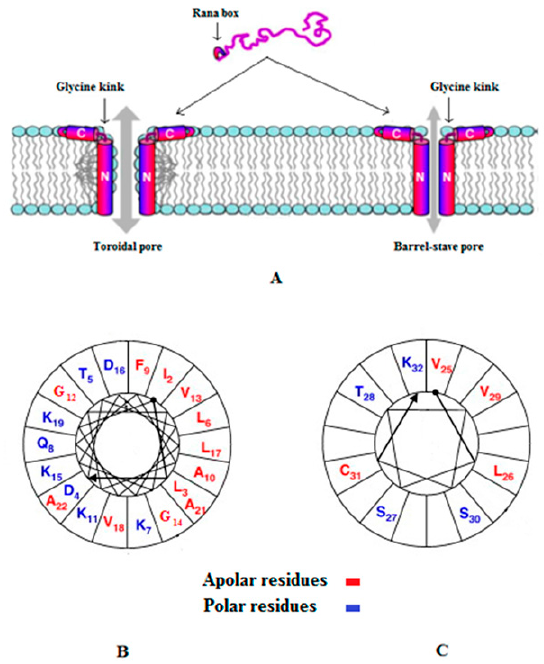
Figure 1. Models for the membrane pore formation by E2EM. Figure 1 was revised from [115] and mechanisms (Table 1) and are the best supported experimentally. In both models, the N-terminal 23 residues of the peptide spans the bilayer and a glycine kink orientates the 7 residue, C-terminal Rana box region of E2EM to lie parallel to the membrane surface. In this orientation, the Rana box region of the peptide, which is a cystein stabilized macrocyclic structure, interacts with the lipid head-group region of the membrane and stabilizes pore formation by E2EM [115]. The major difference between these models is that in the toroidal pore mechanism, the membrane leaflets deform to allow the lipid head-group region to remain in contact with the hydrophilic face of the E2EM membrane spanning region, which is not observed in the barrel stave mechanism [23]. For clarity, two monomers of E2EM are shown in the schematic pore above but oligomers formed by between five and ten peptide molecules have been proposed [115,120]. Similar models of membrane interaction appear to apply to the linear reduced form of the peptide [115], which is represented in our studies as E2EM-lin. Figure 1B,C show two-dimensional axial projections [126] for the membrane spanning region and Rana box domain of E2EM, respectively, that are involved in pore formation by the peptide. In both cases, these segments for amphipilic α -helices with wide hydrophobic faces that our data suggest would be maximized by alkaline pH, thereby promoting the potential for the mutual interaction of E2EM monomers and the formation of multimeric species involved in pore